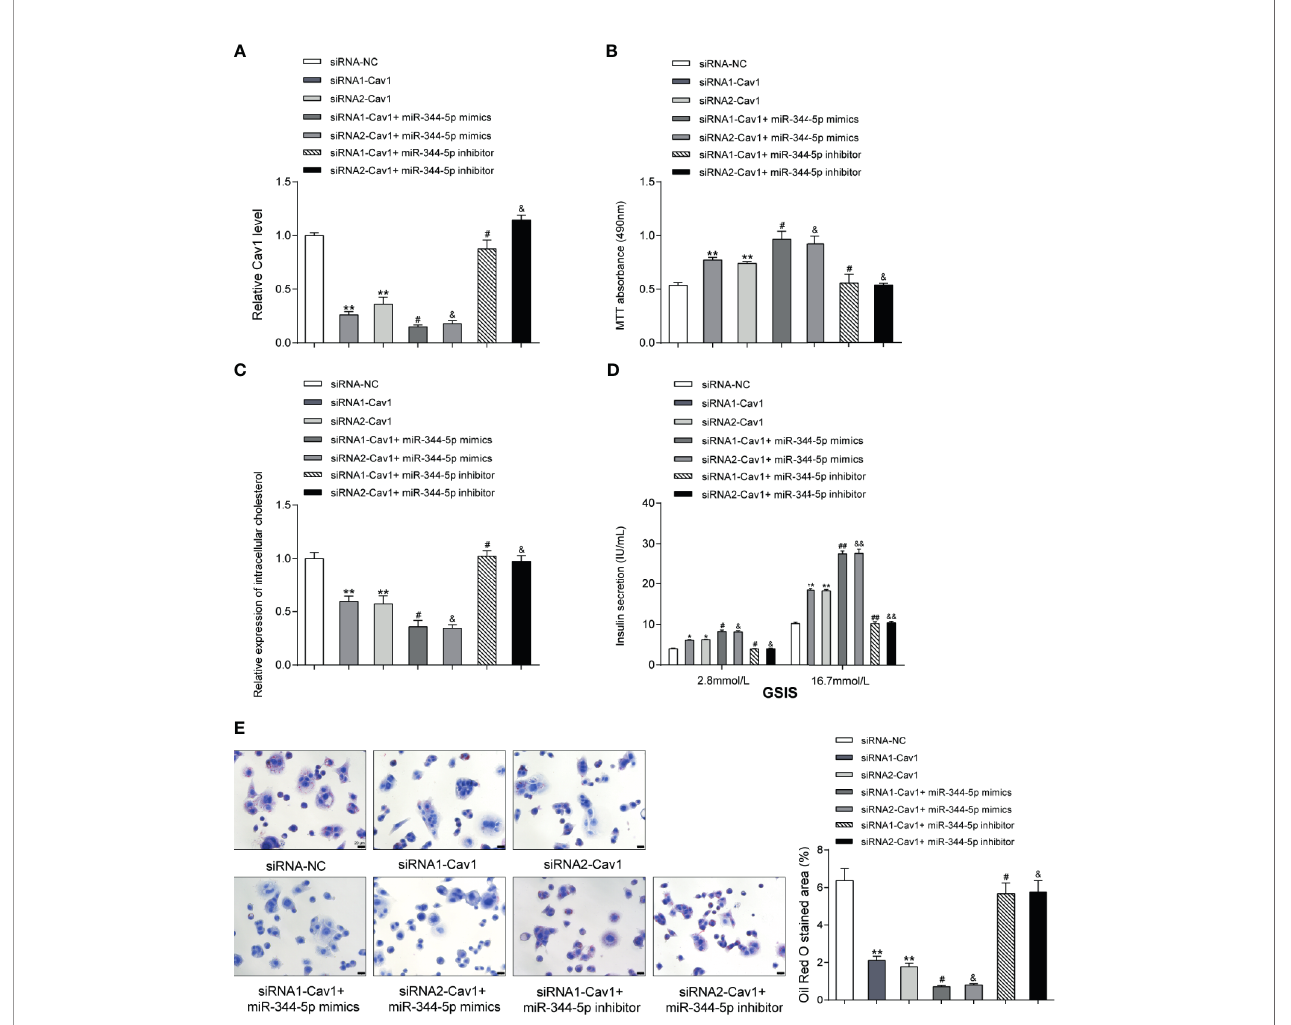
FIGURE 5 | miR-344-5p protects against cholesterol-induced b -cell dysfunction through Cav1. (A) Cav1 silencing was achieved in INS-1 cells by transfecting small interfering RNA targeting Cav1 (siRNA1-Cav1 or siRNA2-Cav1); si-NC was transfected as a negative control. The transfection ef fi ciency was veri fi ed using real-time PCR 48 h after transfection. Then, INS-1 cells were divided into seven groups: siRNA-NC group, siRNA1-Cav1 group, siRNA2-Cav1 group, siRNA1-Cav1+ miR-344-5p mimics, siRNA2-Cav1+ miR-344-5p mimics, siRNA1-Cav1+ miR-344-5p inhibitor, and siRNA2-Cav1+ miR-344-5p inhibitor. INS-1 cells in each group were transfected accordingly, treated with 5 mM cholesterol for 12 h, and examined for the expression of Cav1 by real-time PCR. (B) The cell viability was determined by MTT assay. (C) The intracellular cholesterol levels were examined by cholesterol assay kits. (D) The GSIS was determined by an insulin ELISA kit; (E) the fat droplets deposition was determined by Oil Red O staining. ** P < 0.01 compared to siRNA-NC; # P < 0.05 compared to siRNA1-Cav1 group; & P < 0.05 compared to siRNA2-Cav1 group. *p < 0.05, ## p < 0.01, && p <